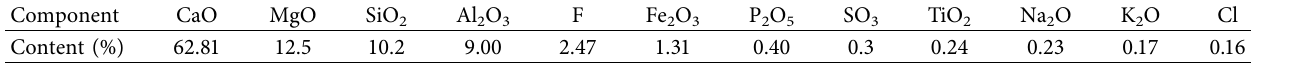
Table 2: Major chemical components of the alkaline residue.